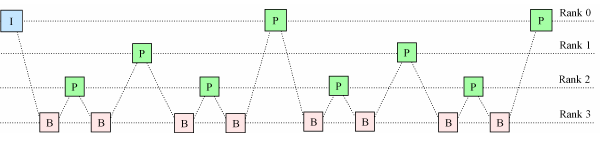
Fig. 2: HPR Coding